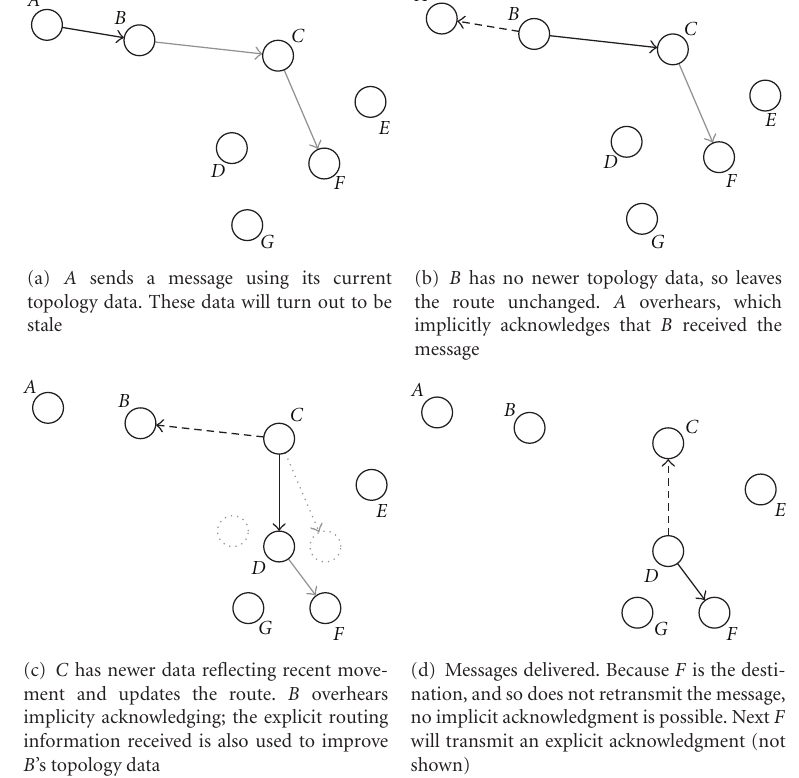
Figure 3: An example of LASR’s route handling, where an inaccurate route is automatically corrected. For clarity, only the overheard message at the previous transmitter is shown. In actuality, some or all of the other nodes would detect or overhear each transmission, improving the topology data in those other